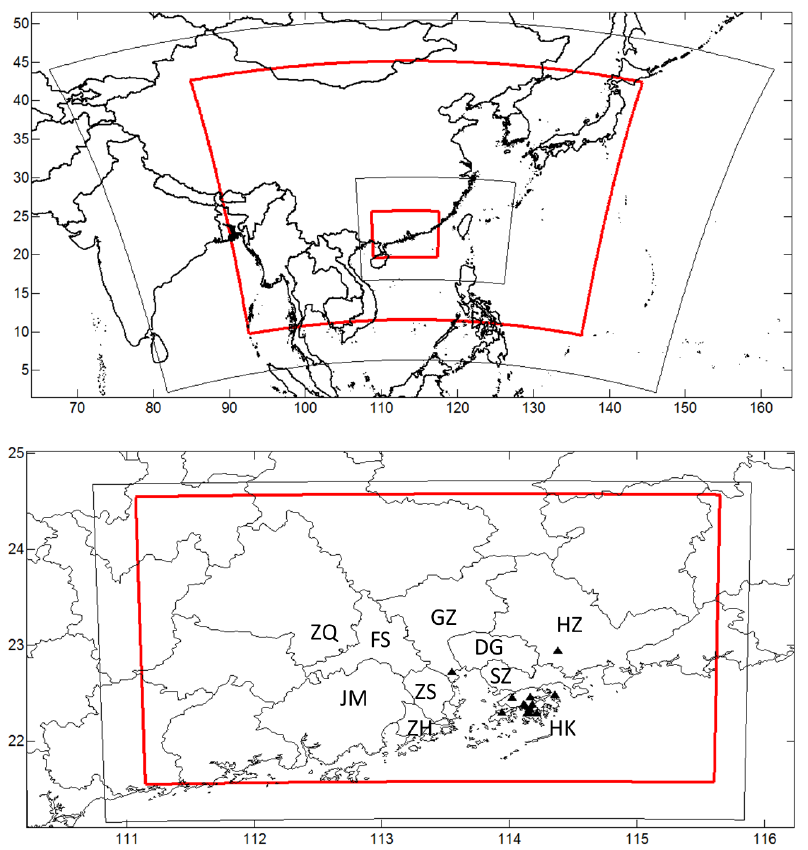
Figure 1. Model domain setting and air quality station location (triangles). HK, Hong Kong; SZ, Shenzhen; DG, Dongguan; HZ, Huizhou; GZ, Guangzhou; FS, Foshan; ZQ, Zhaoqing; JM, Jiangmen; ZH, Zhuhai; ZS, Zhuhai.